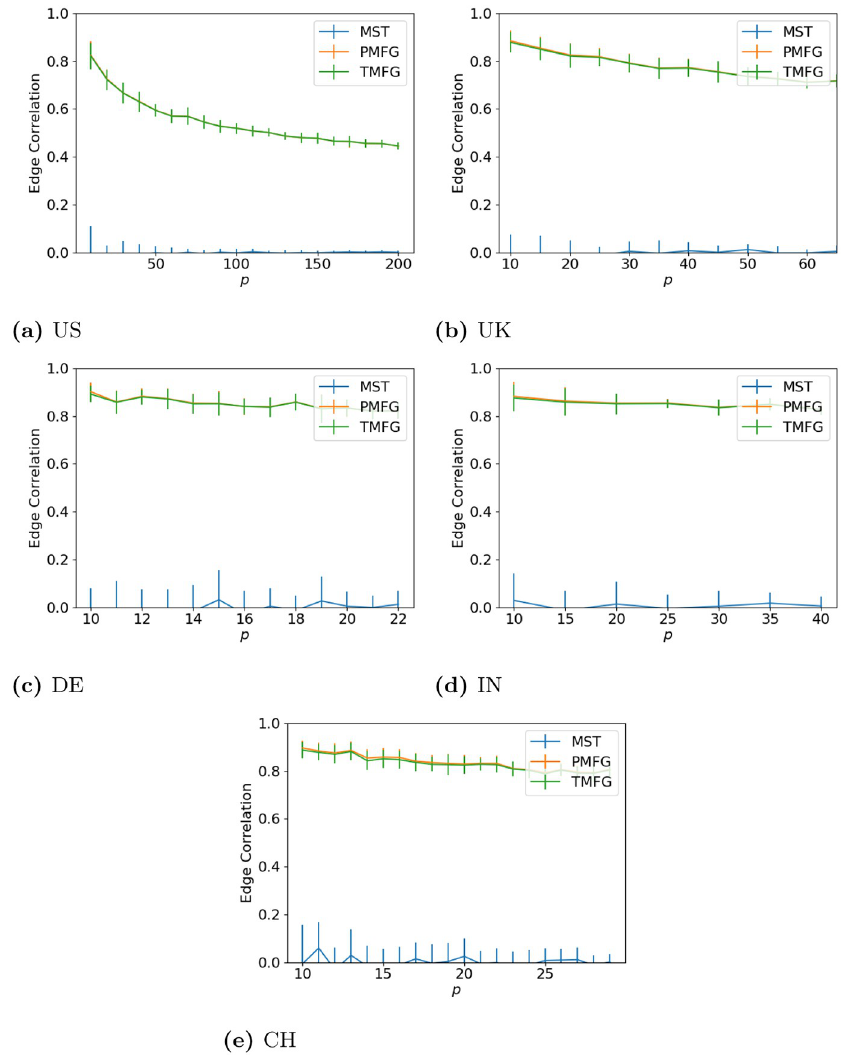
Fig 6. Agreement between edges between the full and filtered correlation matrices with different values of p for the window with lowest volatility. (a) US, (b) UK, (c) DE, (d) IN, (e)